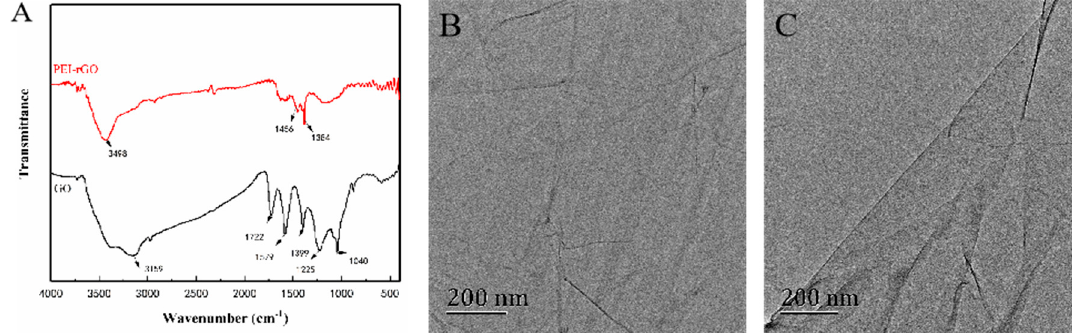
Figure 2. ( A ) FTIR spectra of the GO and the PEI-rGO. TEM images of ( B ) the GO and ( C ) the